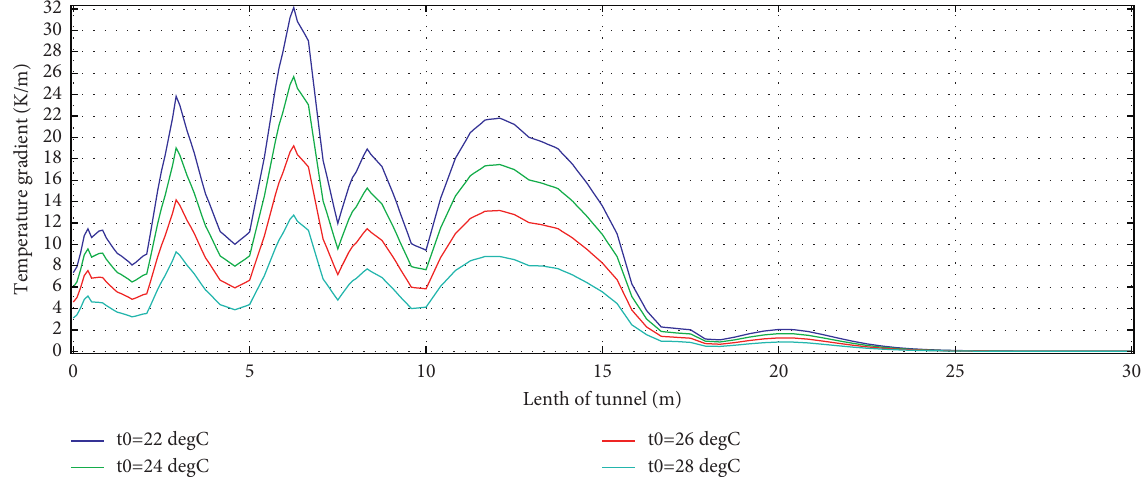
Figure 15: Gradient of air temperature distribution inside the tunnel at different air